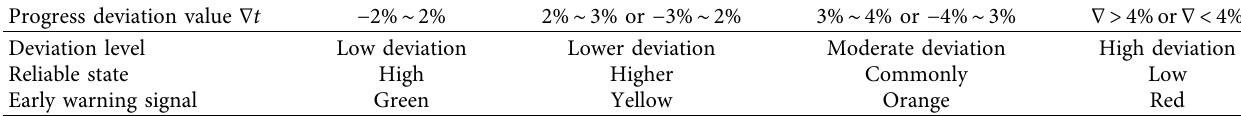
Table 1: Construction schedule reliability control early warning